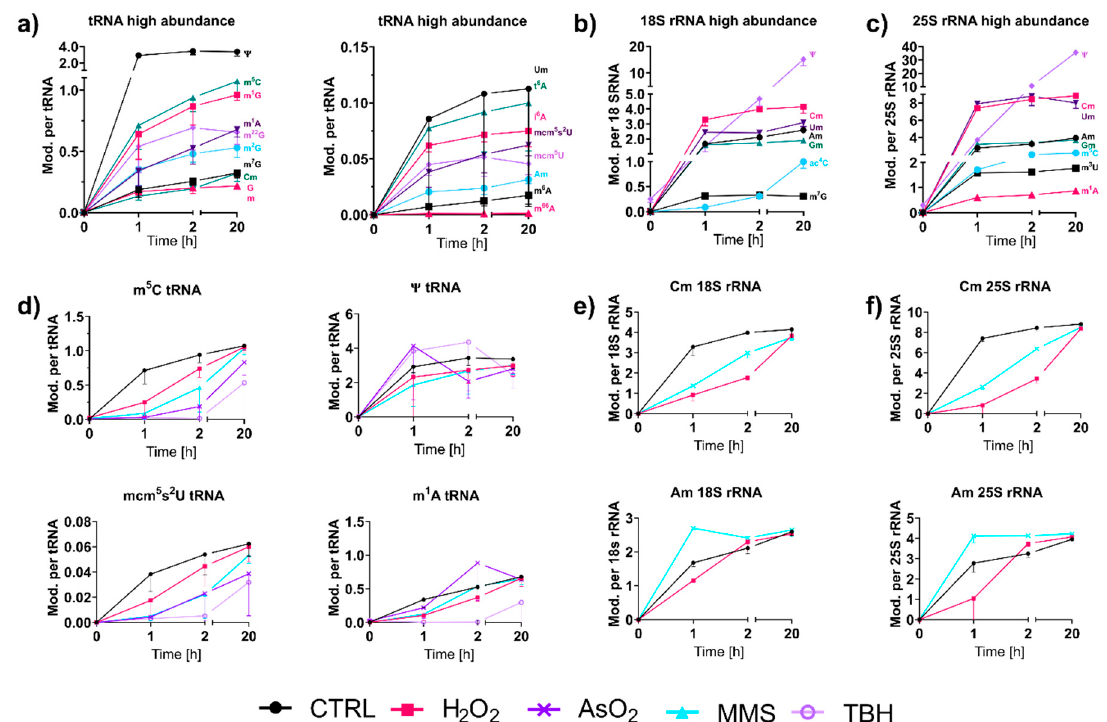
Figure 5. Incorporation of RNA modifications into new transcripts over time. Cells were initially grown in medium containing 15 N 2 -uracil, 13 C 6 -glucose; after stress exposure, the cells were cultivated in medium with L-methionine-[ 2 H 3 ]-methyl. ( a ) Abundances of modifications in new tRNA sorted by high and low abundances of modifications. (means of n = 3 and error bars reflect standard deviation). ( b , c ) Abundance of modifications in new 18S ( b ) and 25S ( c ) rRNA. (means of n = 2, and error bars reflect standard deviation). ( d ) A comparison of modification abundances in new total tRNA with dependence on stress. (means of n = 3, and error bars reflect standard deviations). (e and f) A comparison of modification abundances in new 18S ( e ) and 25S ( f ) rRNA in dependence on stress. (means of n=2, and error bars reflect standard deviations).